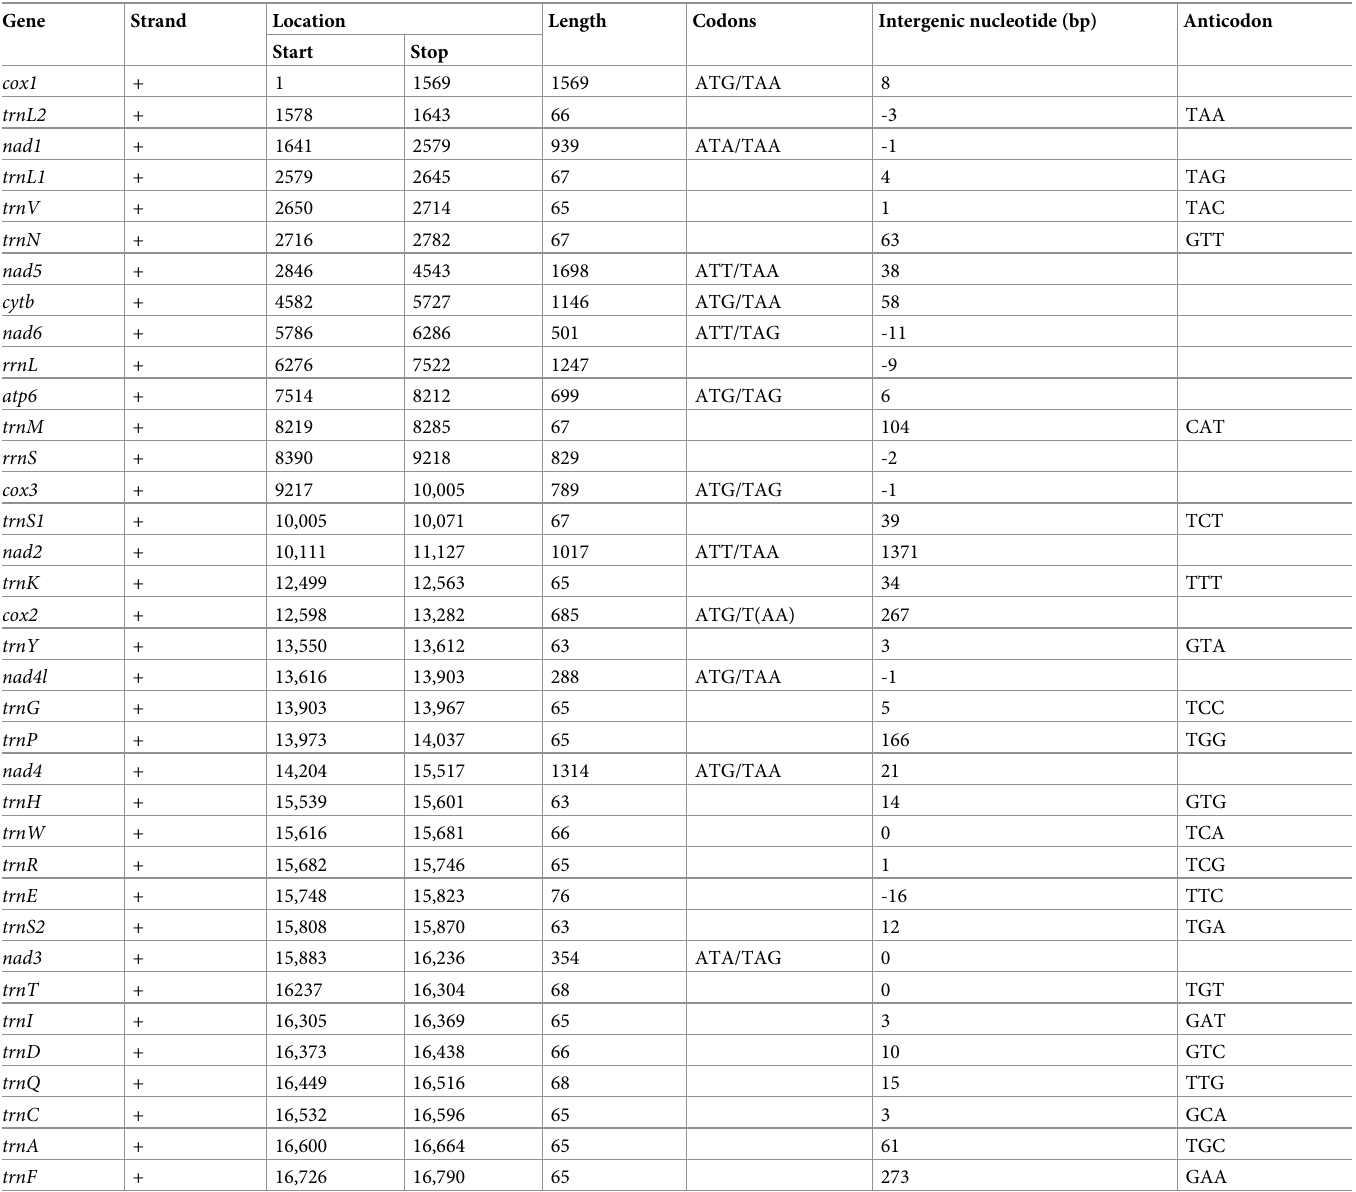
Table 3. Annotation of the S . minima mitochondrial